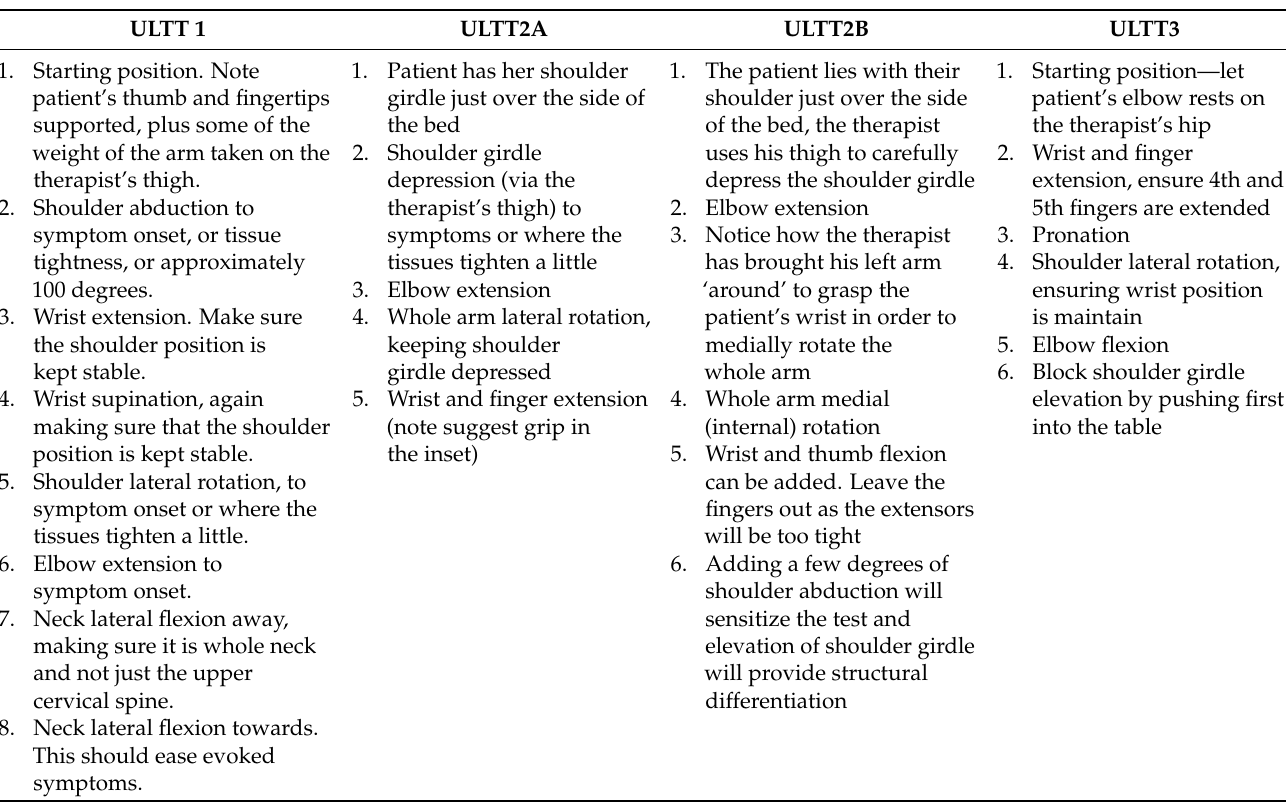
Table 1. Detailed Process of Upper limb tension tests (ULTTs).